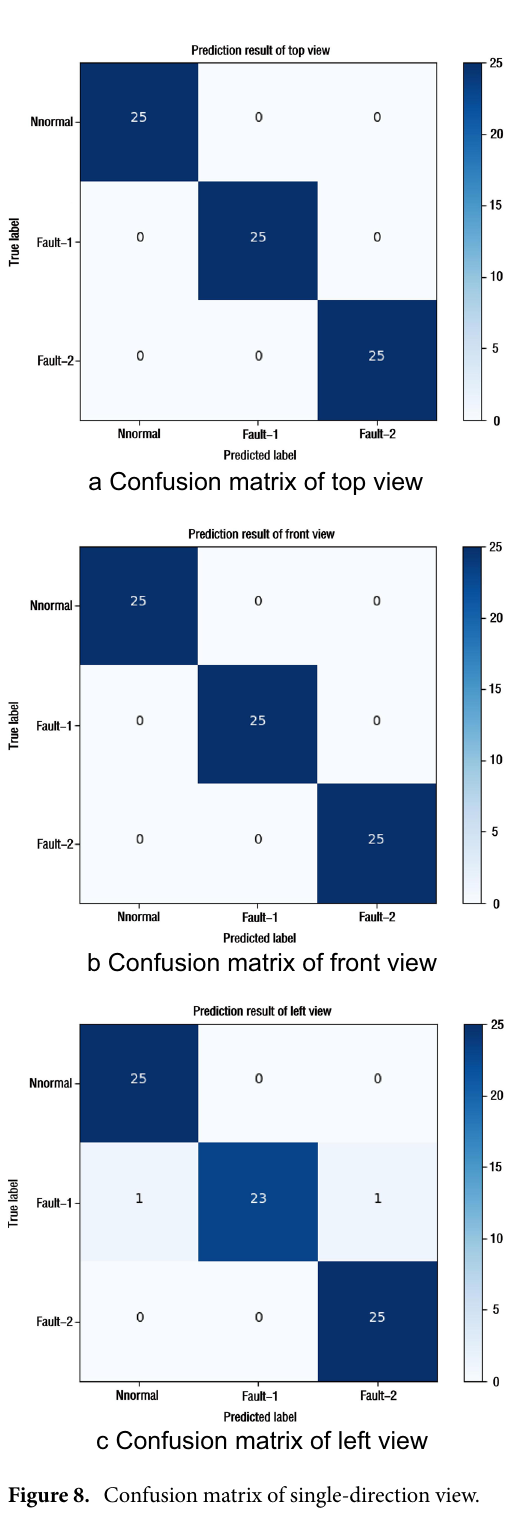
Figure 8. Confusion matrix of single-direction